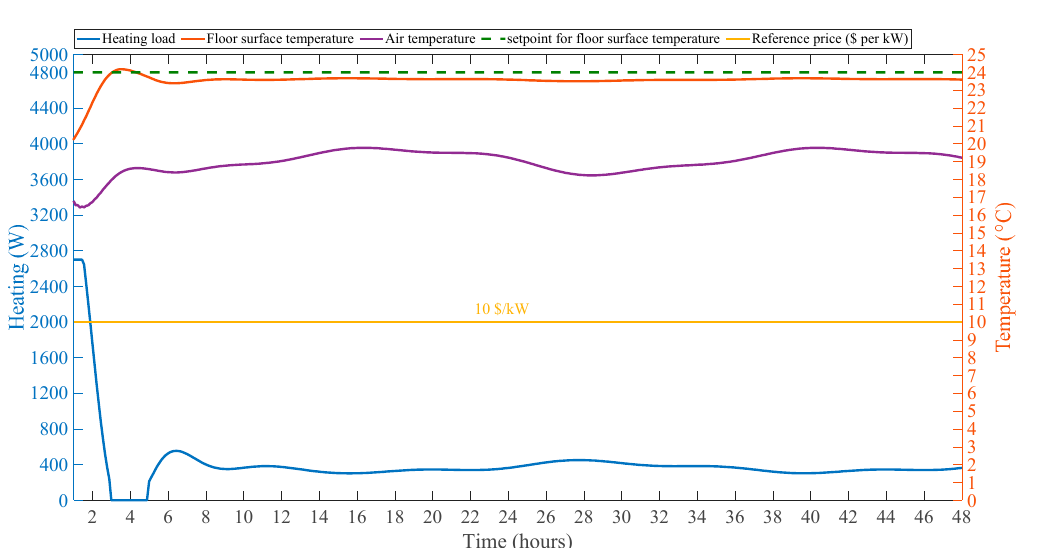
Figure 6. Ambient temperature profile.